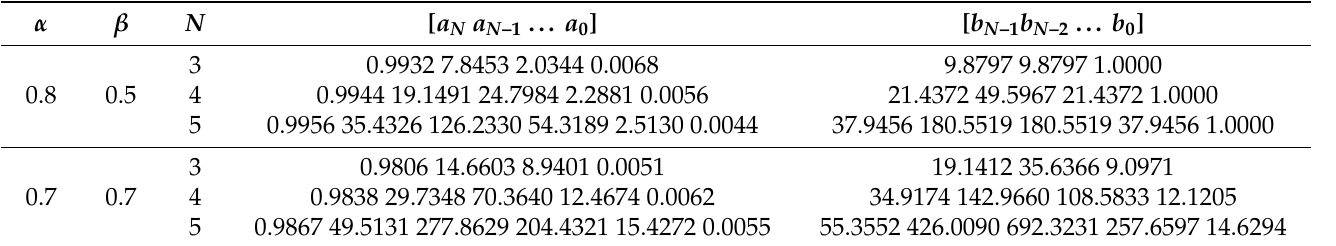
Table 4. Optimal coefficients of the proposed FHPFs for different values of α , β , and N .